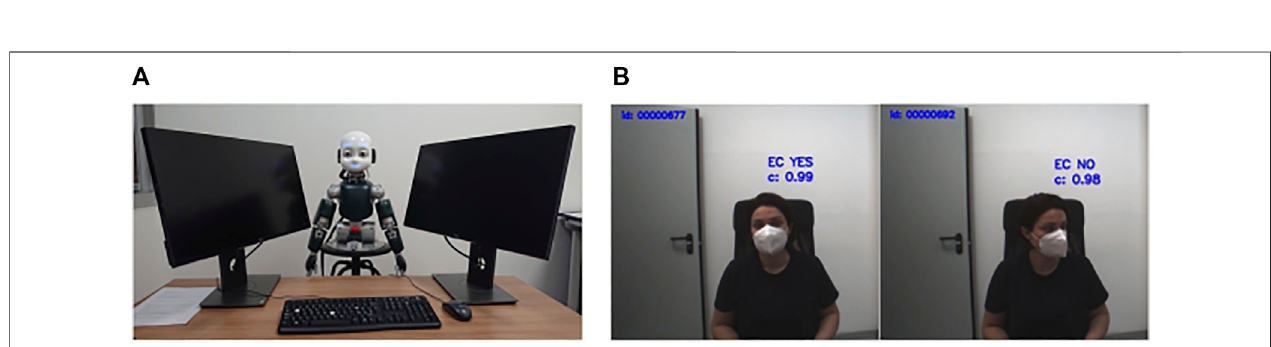
FIGURE 4 | Experimental setup. (A) The iCub is positioned between two lateral screens face to face with the participant at the opposite sides of a desk that is 125 cm wide. (B) Sample frames acquired during the experiment in which the participant fi rst looks at the robot to make an eye contact and then simulates adistraction looking at the lateral screen. On each frame, the prediction (eye contact yes/no) with the con fi dence value c is also reported.